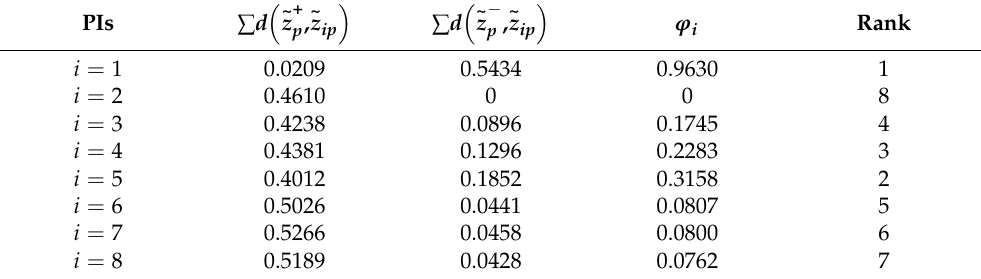
Table 10. The rank of performance